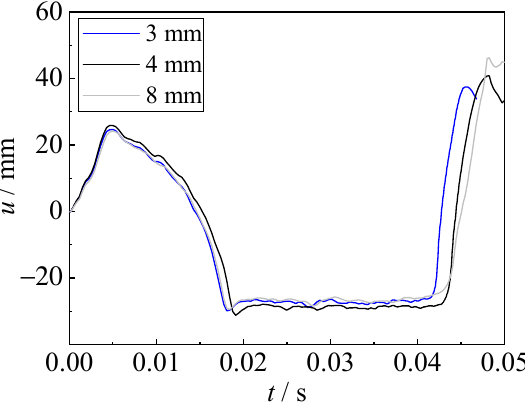
Figure 11. FE model of underwater explosion tests. ( a ) Eulerian elements (air, water, and charge). ( b ) Steel sheet.